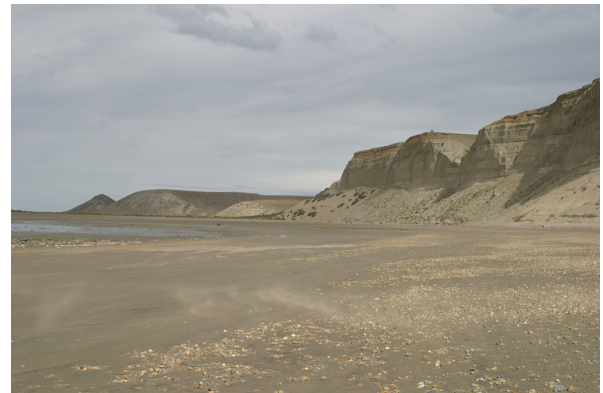
Figure 1. Evidence of the sea driving coastal cliff erosion. The ver- tical shaped cliff in the foreground is similar to the cliff in the back- ground (its smoothed shape), except that the one in the background has been protected from the sea by a sand spit. Obviously, the cliff with sea at its base then retreats more quickly (the cliff face is more or less vertical). Photo from Punta Quilla, Patagonia,